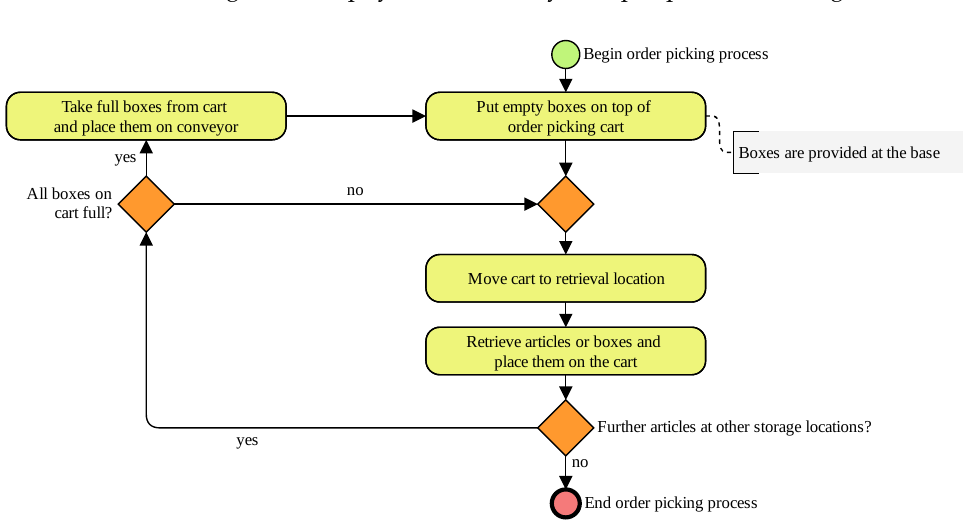
Figure 1. Business process model of logistics Scenario 1—simplified order